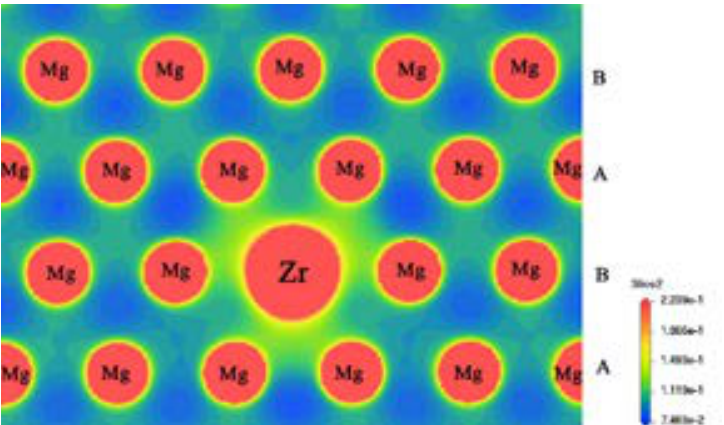
Figure 8. Electron density of (0 0 1) lattice